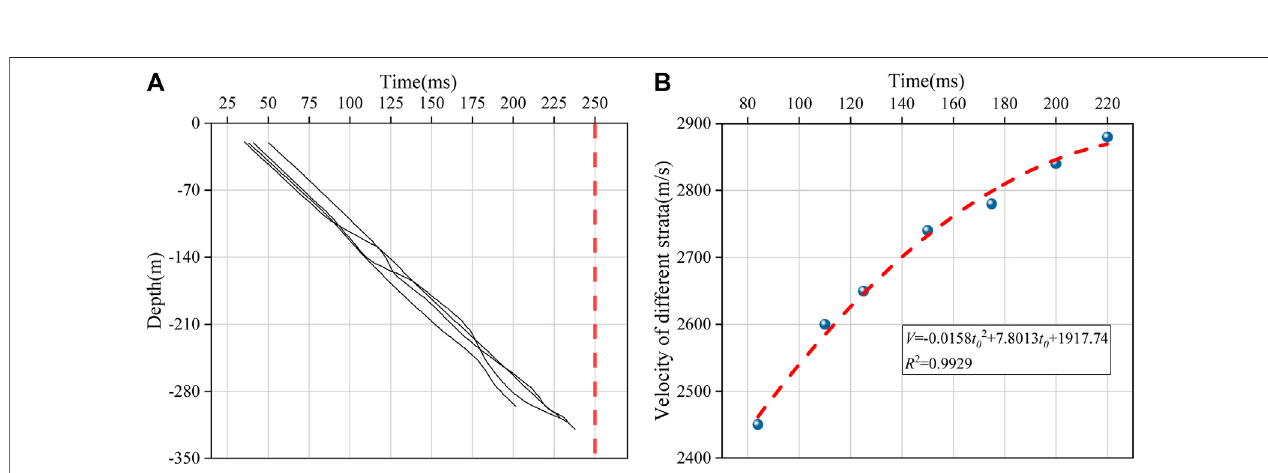
FIGURE 10 | Time-depth conversion of the WCFZ: (A) Velocity fi eld establishment and (B) time-depth conversion velocity diagram of the WCFZ.